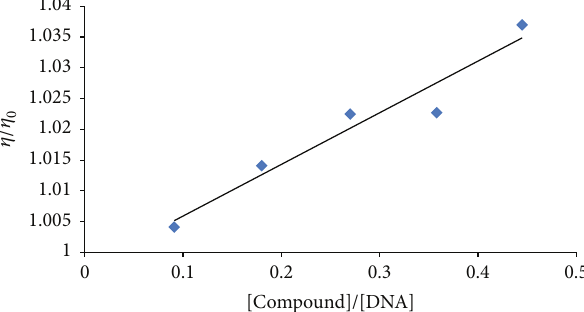
Figure 4: Effect of increasing concentration of compound 1 on the relative viscosity of DNA at 25 ∘ C. [DNA] = 30 𝜇 M and [compound- 1] = 5–25 𝜇 M.